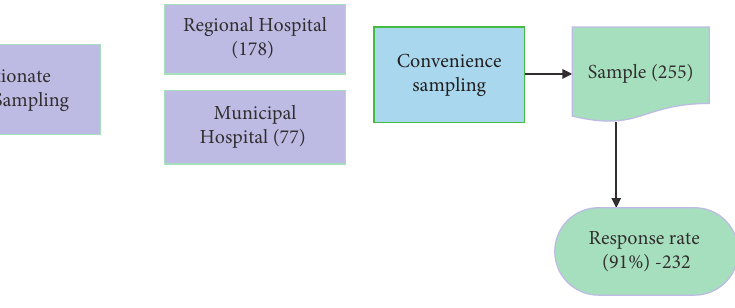
Figure 1: Recruitment Table 1: Nurses’ perception about their professional practice environment.